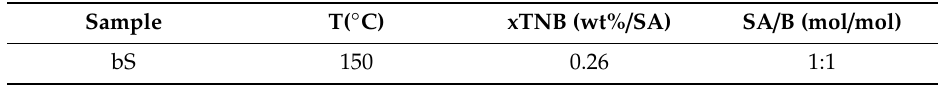
Table 1. Experimental reaction conditions for the synthesis of bS polyol. T ( ◦ C): process temperature; SA: succinic acid; B: 1,4-butanediol; xTNB: catalyst weight percent referred to SA.